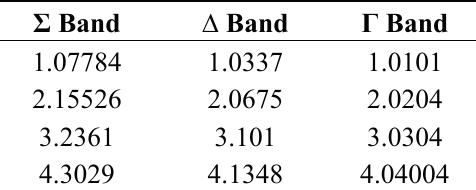
Table 1. The energy spacing values